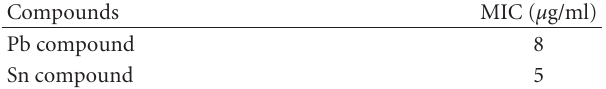
Table 1: The minimal inhibitory concentration (MIC) of Triph- enyltin chloride and Triphenyllead chloride for Saccharomyces cerevisiae growth. Compounds MIC ( μ g/ml) Pb compound 8 Sn compound 5